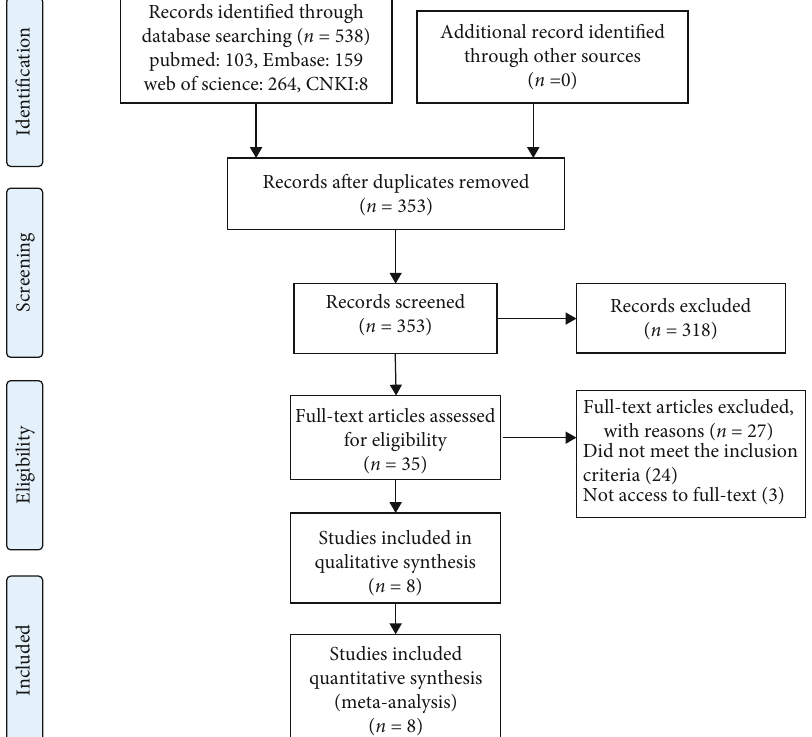
Figure 1: PRISMA fl ow diagram of the literature retrieval and selection process. CNKI: China National Knowledge